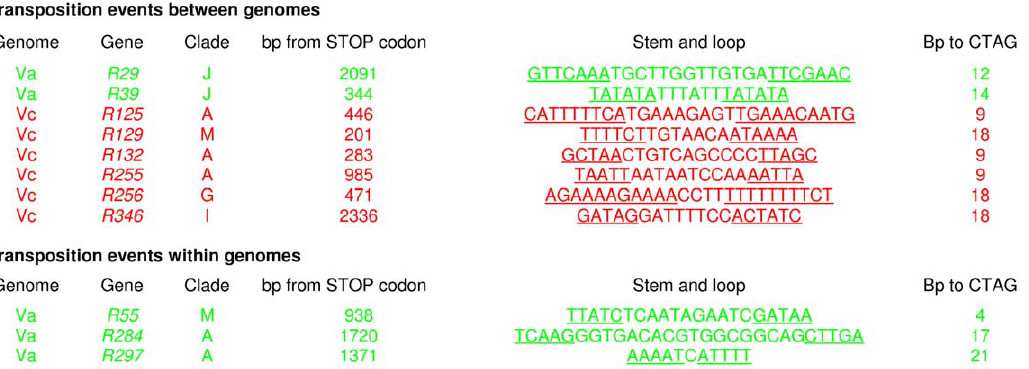
Figure 4. NBS - R genes showing features of residual helitron activity. The CTAG tetranucleotide and of the inverted repeat forming a stem and loop structure (underlined) are shown. The numbers of nucleotides between the two gene regions are also indicated.